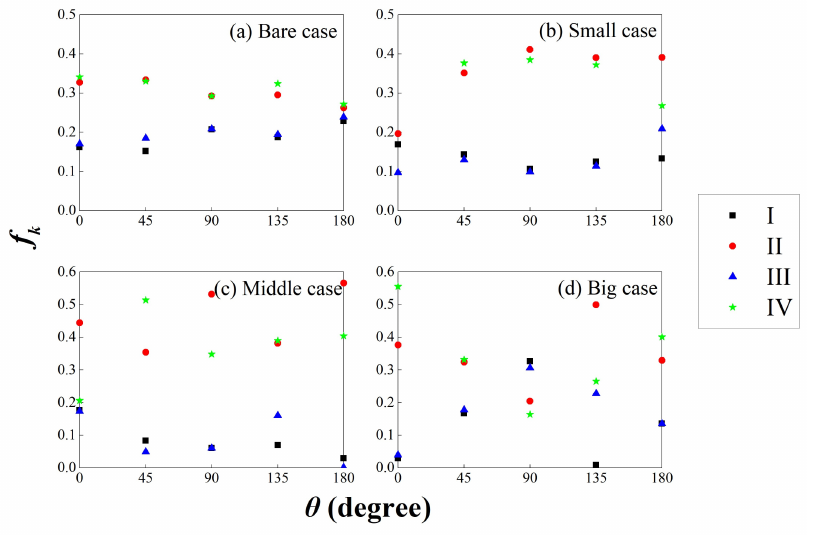
Figure 6. Frequency of occurrence of coherence turbulent events for different cases ( Q = 0.030 m 3 s − 1